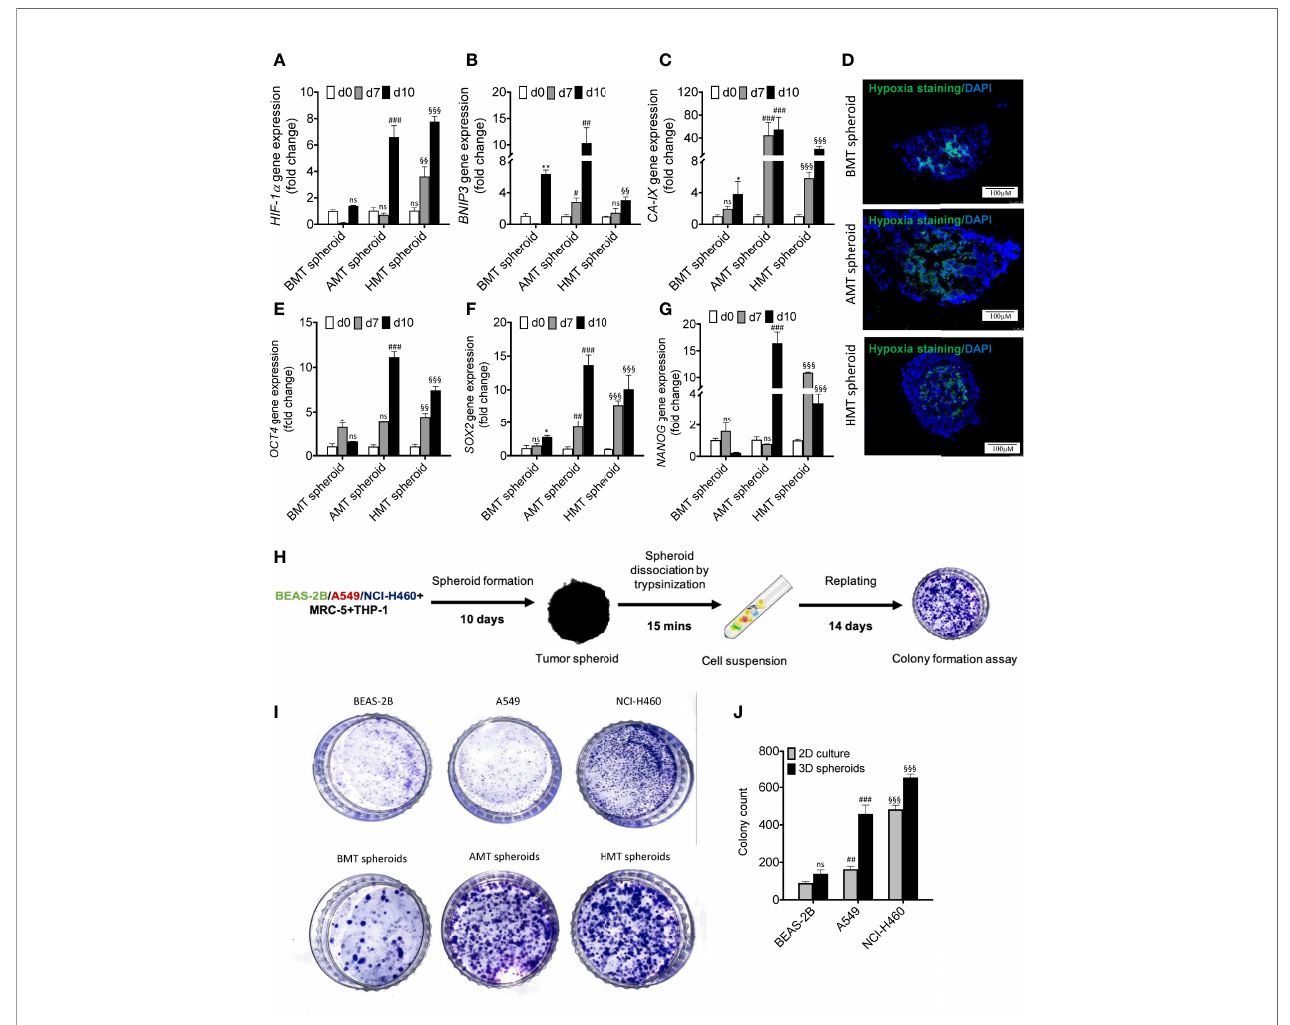
FIGURE 3 | Assessment of TME features in multicellular 3D spheroids. (A – C) RT-qPCR analysis of hypoxia-regulated gene expressions such as HIF-1 a (A) BNIP3 (B) and CA-IX (C) in BMT, AMT, and HMT spheroids on day 0, day 7, and day 10. (D) Image-iTGreen hypoxia stainingin BMT, AMT, and HMT spheroid sections (6 micron). DAPI was used for nuclei counterstaining. (E – G) RT-qPCR analysis of pluripotency markers gene expressions such as OCT4 (E) , SOX2 (F) , and NANOG (G) in BMT, AMT, and HMT spheroids on day 0, day 7, and day 10. (H) Schematic diagram representing methodology adopted for colony formation assay using multicellular spheroids. (I, J) Clonogenic assay was performed with BEAS-2B, A549, and NCI-H460 cell lines and with cancer cell suspension of BMT, AMT, and HMT spheroids, photographed and quanti fi ed (J) GAPDH was used as loading control for RT-qPCR analysis. Fold change was calculated keeping the 2D cells at day 0 as control. We compared the gene expression pro fi les over time in each spheroid separately. All experiments were performed in triplicates (n=3). Data represented as mean ± S.D. 2D vs BMT over time *p< 0.05, **p< 0.01; BMT vs AMT over time #p< 0.05, ## p< 0.01, ### p< 0.001; BMT vs HMT over time §§ p< 0.01, §§§ p< 0.001; ns, non-signi fi